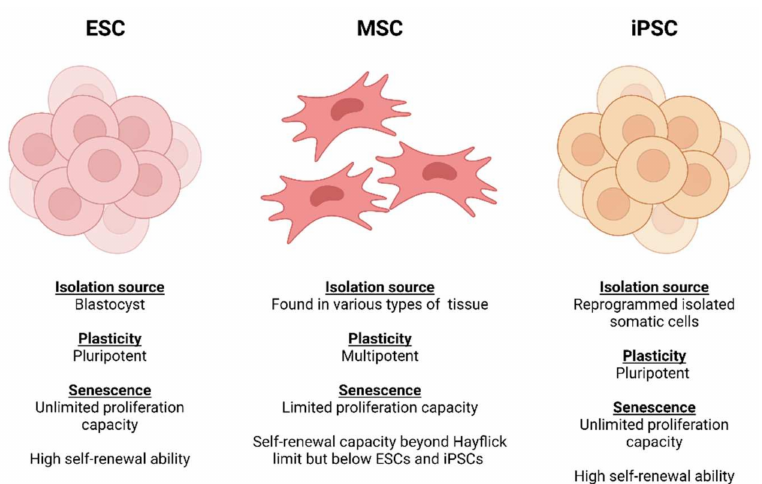
Figure 4. Comparisons of plasticity potential, source of extraction and senescence between stem cell sources (Created with Biorender.com, accessed on 8 January